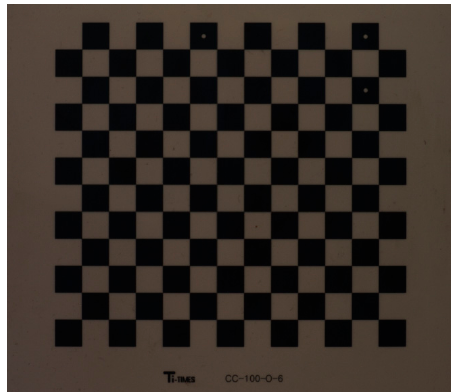
Figure 8. The image of the checkerboard.